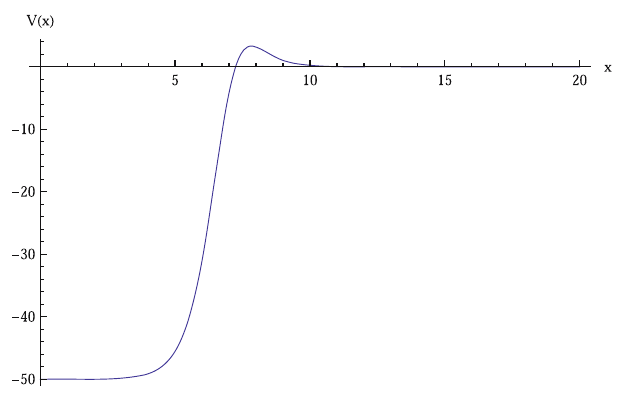
Figure 5: Behavior of Woods - Saxon